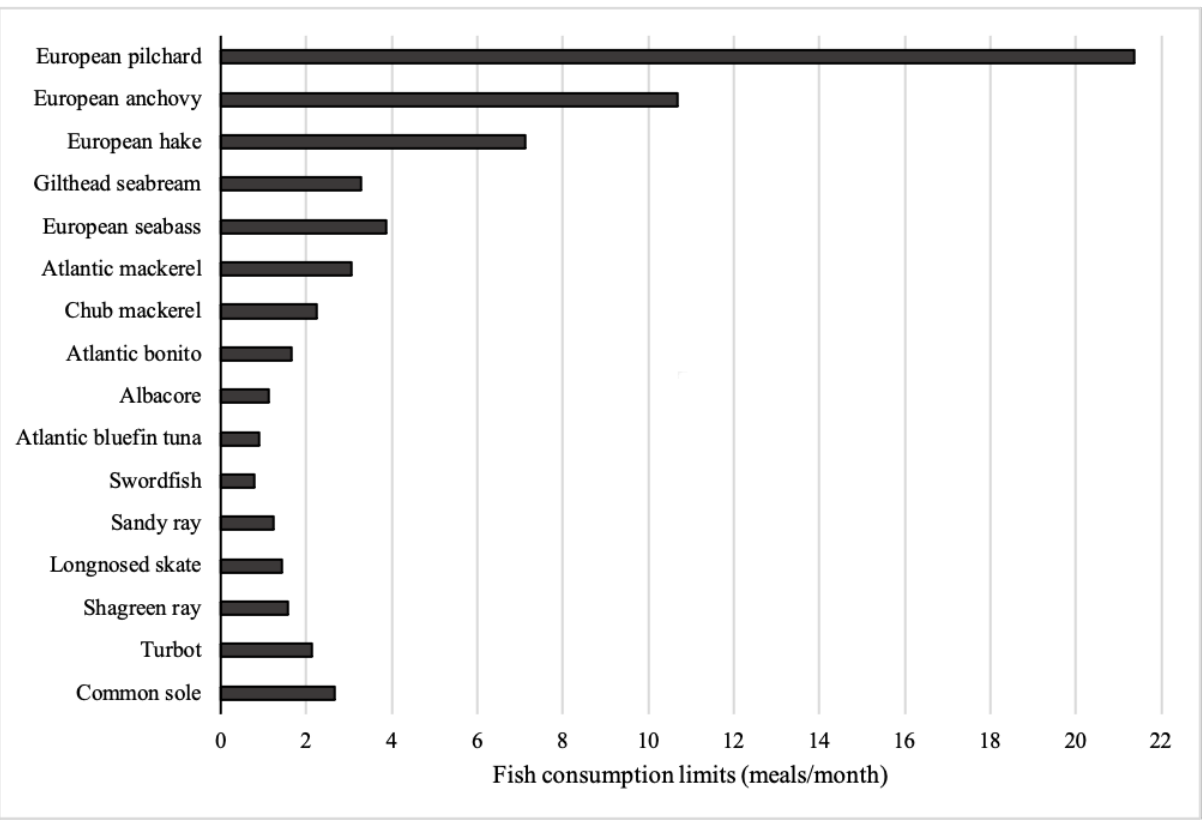
Figure 3. Maximum allowable fish consumption rate in meals/month (CR mm ) for children without adverse health effects.